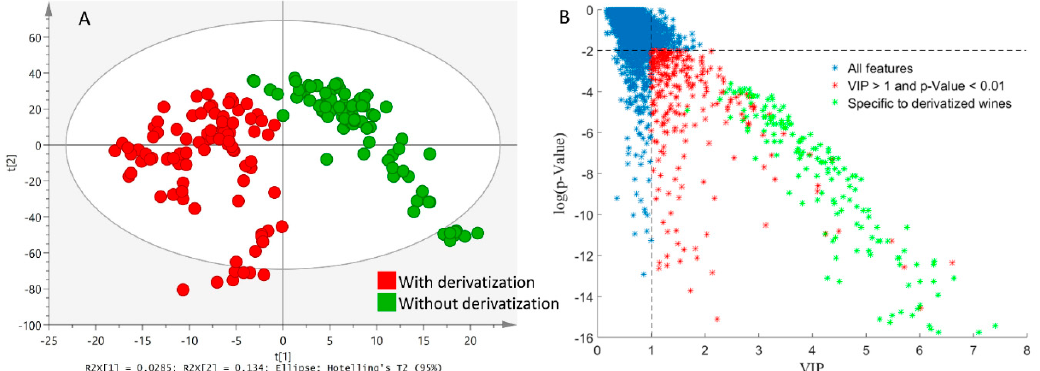
Figure 4. ( A ) Partial least squares discriminant analysis (PLS-DA) model for 92 wines with and